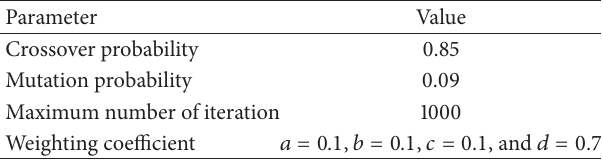
Table 2: Parameter value for mobile user classification.